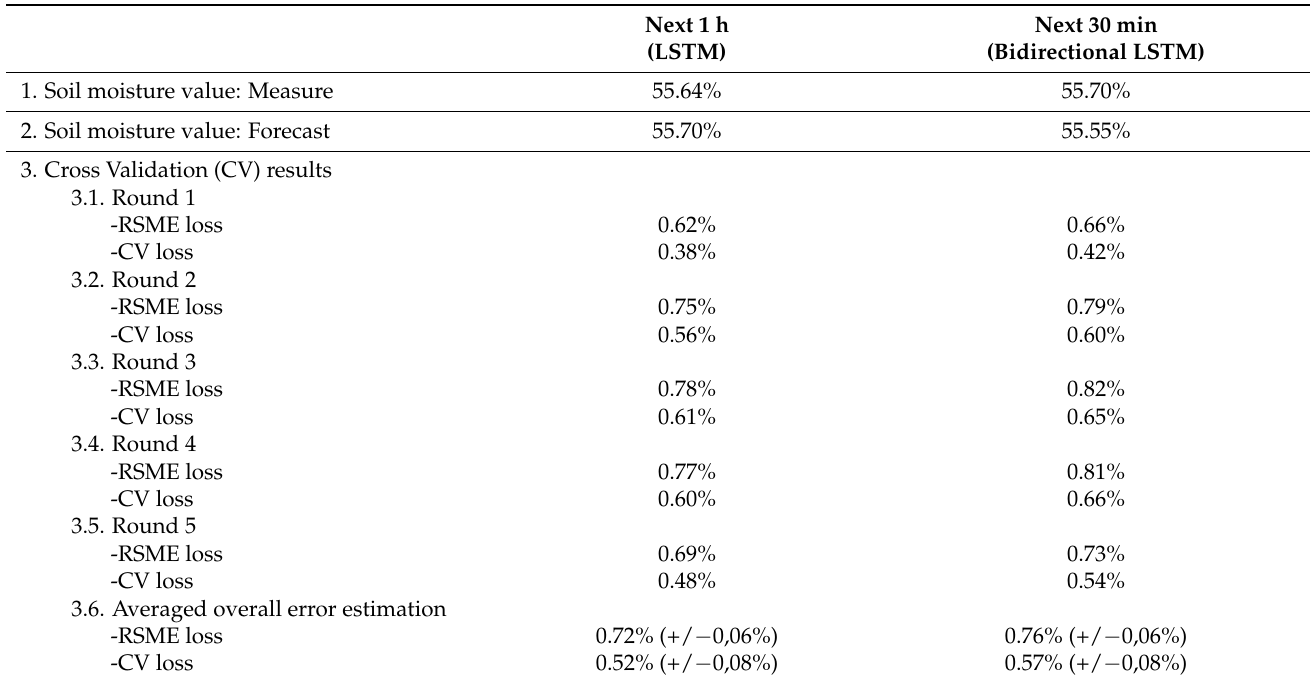
Table 8. Comparison of cross-validation result of soil moisture forecasting model (LSTM and Bi-LSTM).